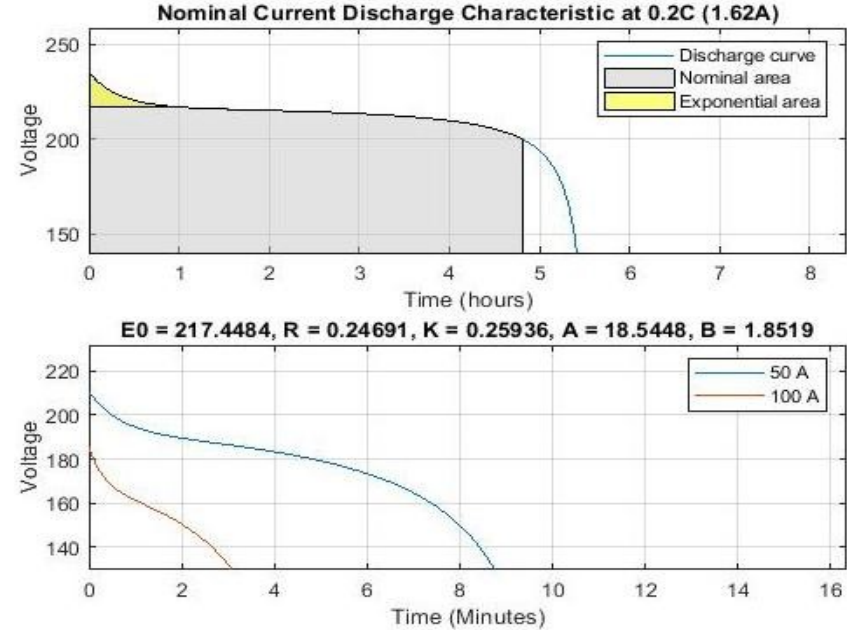
Figure 11. Characteristics of the discharge current of a NiMH battery.